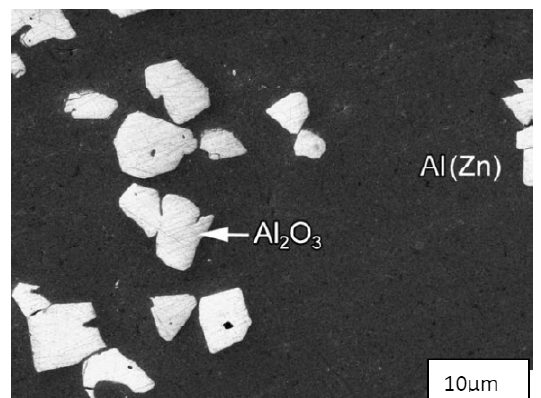
Fig. 8 . SEM micrograph of the oil-quenched which shows that the average size of the Al are about 10 µm. Structural defects such as cracks or voids have not been found in the Al/ Al